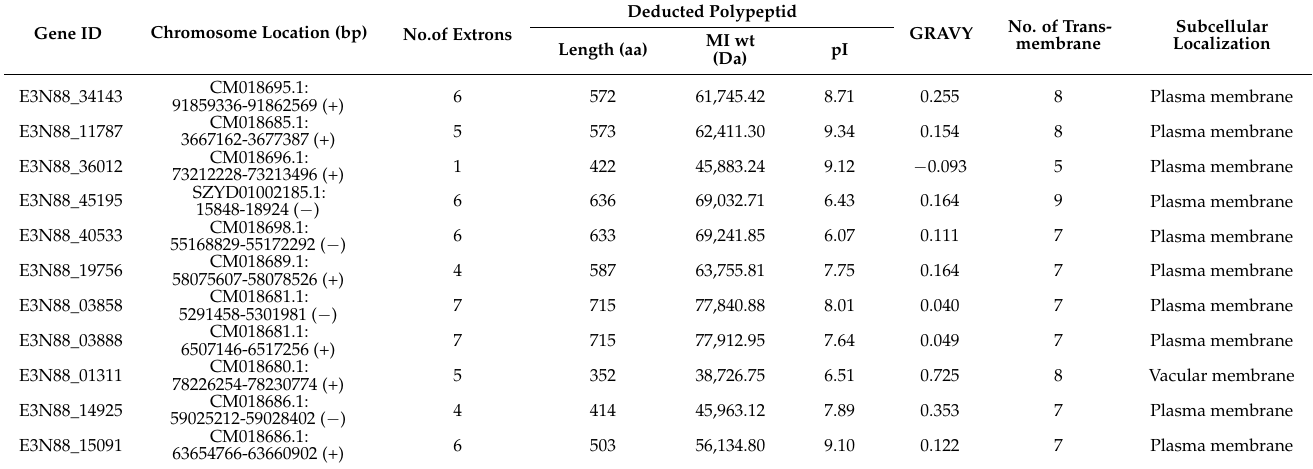
Table 1. Information on PIN genes and properties of the deduced proteins in M. micrantha . Deducted Gene ID Chromosome Location (bp) No.of Extrons